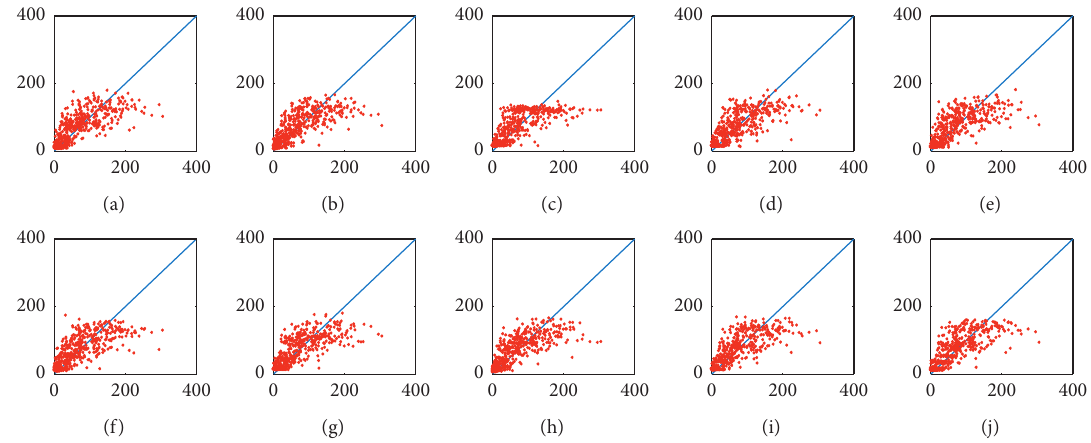
Figure 9: Scatter plots between downscaled results and observed precipitation in the period of 1961–2005 for RF. Horizontal axes show observed precipitation, and vertical axes show the RF results. (a) AC10, (b) AC13, (c) GG, (d) GH, (e) GM, (f) GR, (g) IN, (h) Nor, (i) MME, (j) BMA.